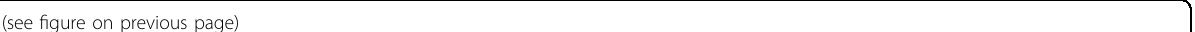
Fig. 5 Persistence of neocortex expansion and increased cortical neuron numbers in adult cKI f/ + mice. a Dorsal view of adult WT and cKI f/ +